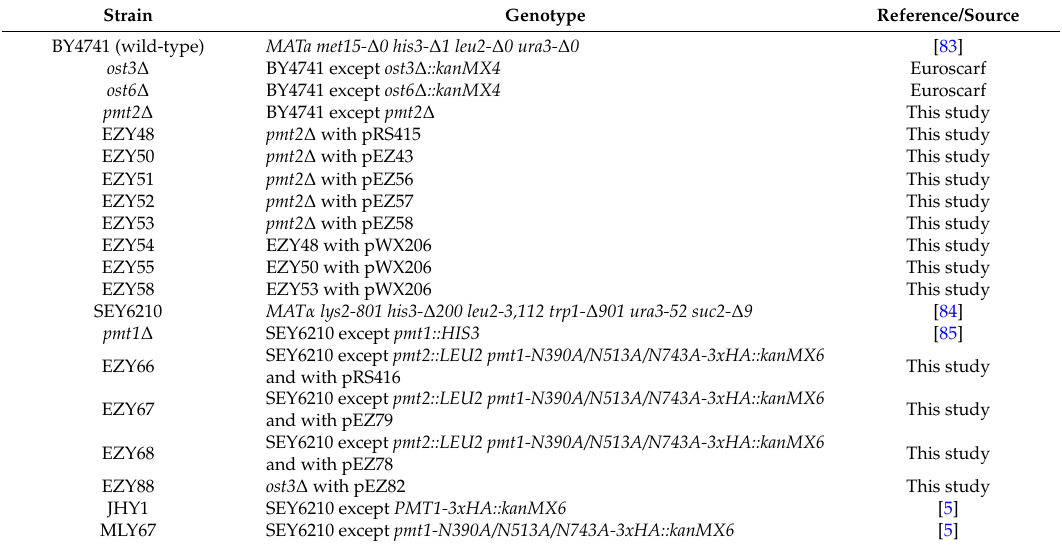
Table 3. Saccharomyces cerevisiae